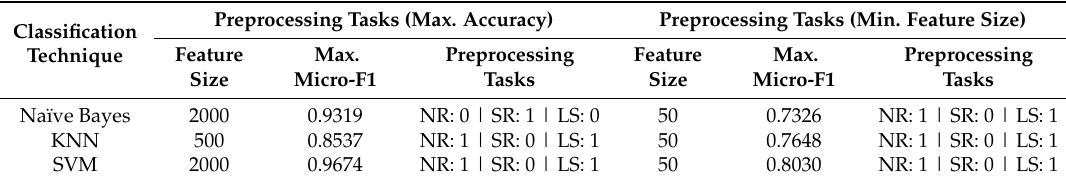
Table 8. Preprocessing tasks (maximum accuracy vs. minimum feature size).